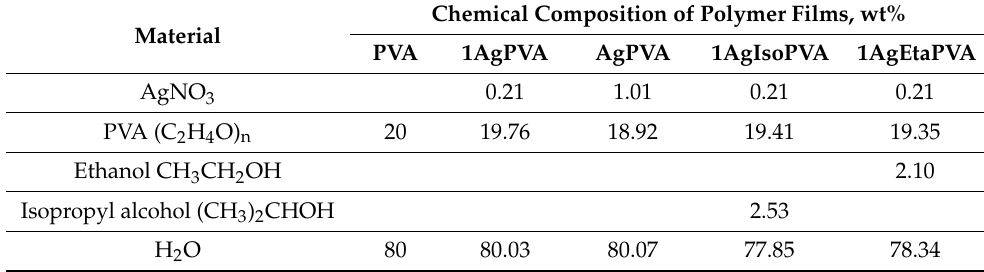
Table 2. Chemical composition of prepared PVA films with